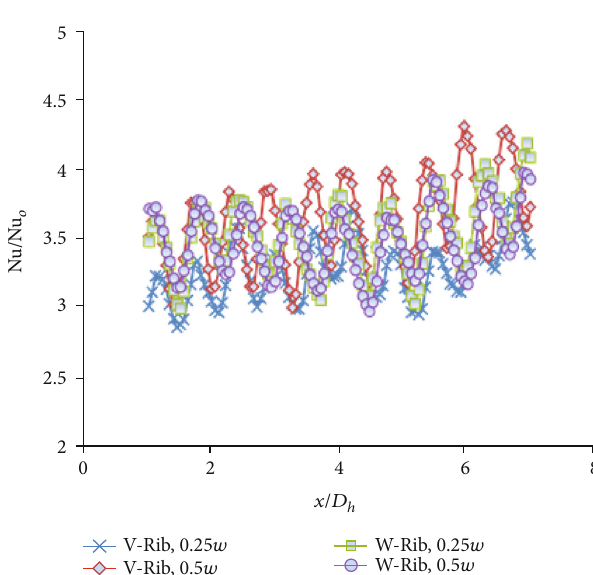
Figure 8: Streamwise variation of Nu/Nu